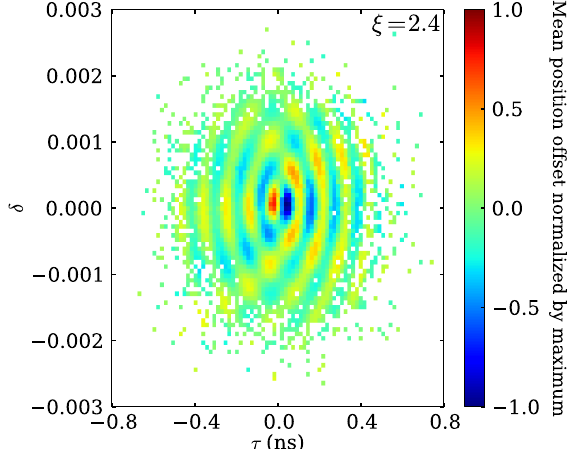
FIG. 11. Scatter plot of populated bins in synchrotron phase space for the lengthened Gaussian bunch at the end of a macroparticle simulation of a coupled-bunch instability at a chromaticity of 2.4. The color of each point represents the mean offset of particles within that bin.